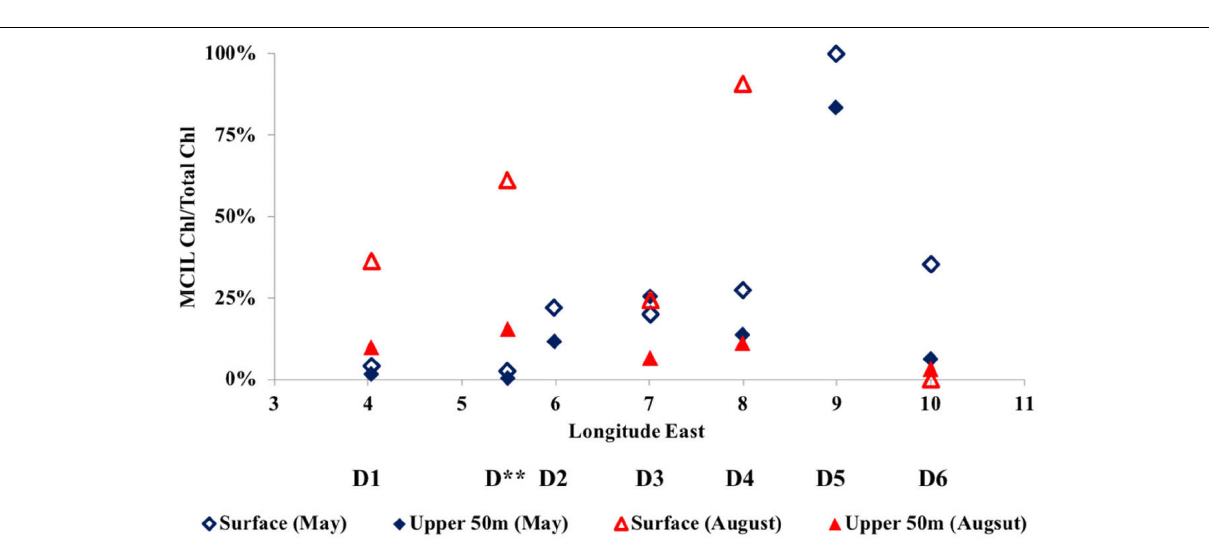
the mixed layer in May to 2–3% in August due to the lower abundance of mixotrophic